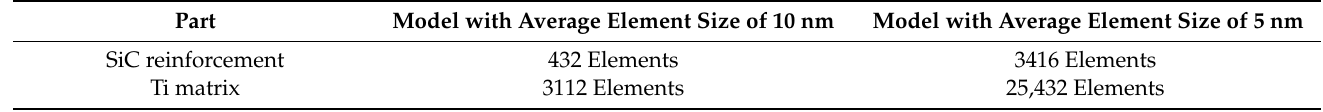
Table 5. Characteristics of two different meso-scale models for the mesh convergence study.